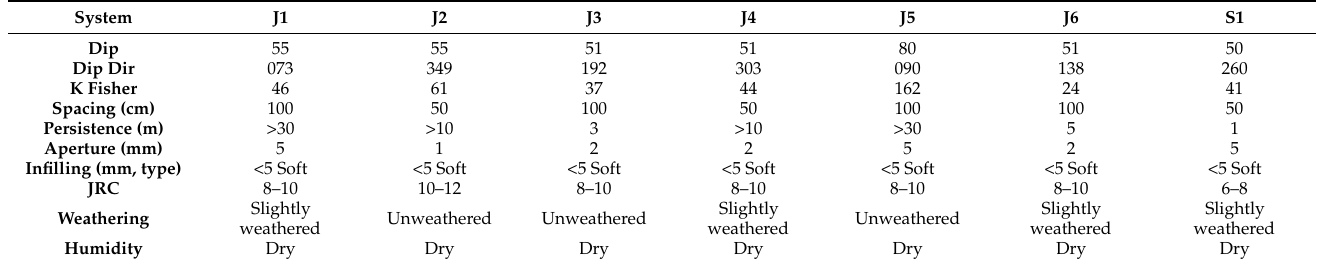
Table 3. Geo-mechanical characteristics of the different discontinuity sets; J = joint, S = schistosity.